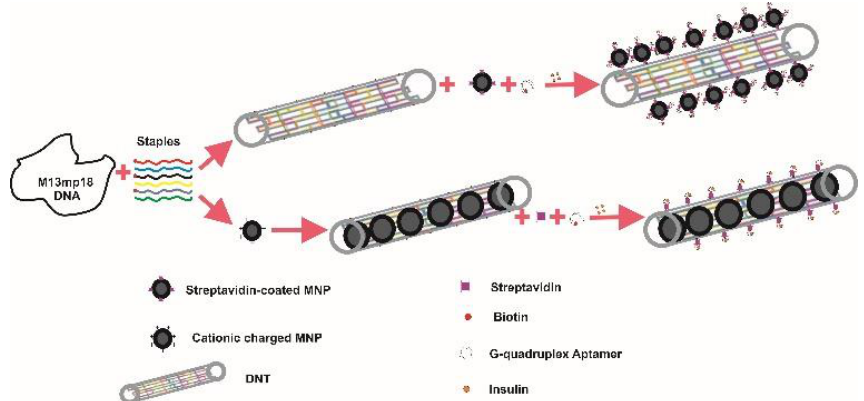
Fig. 1. Graphical abstract of MDNTs fabrication with DNA origami as a colorimetric sensing platform